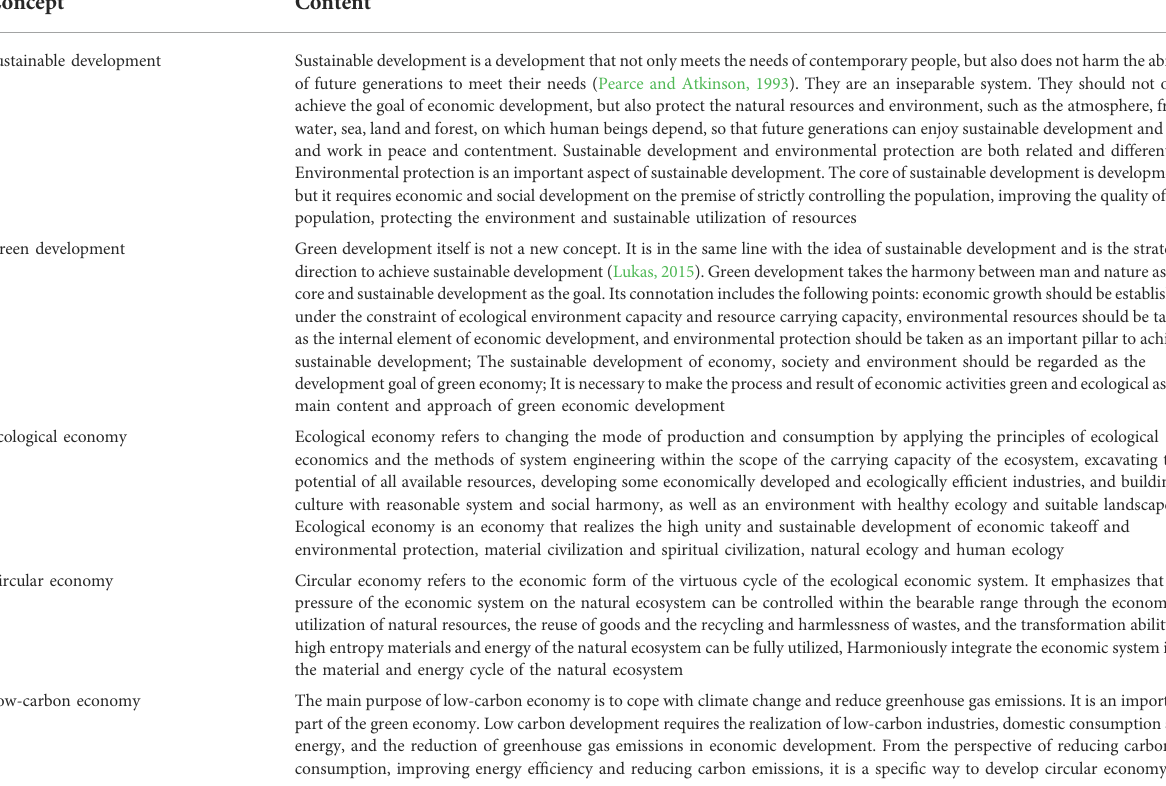
TABLE 1 Related concepts of green